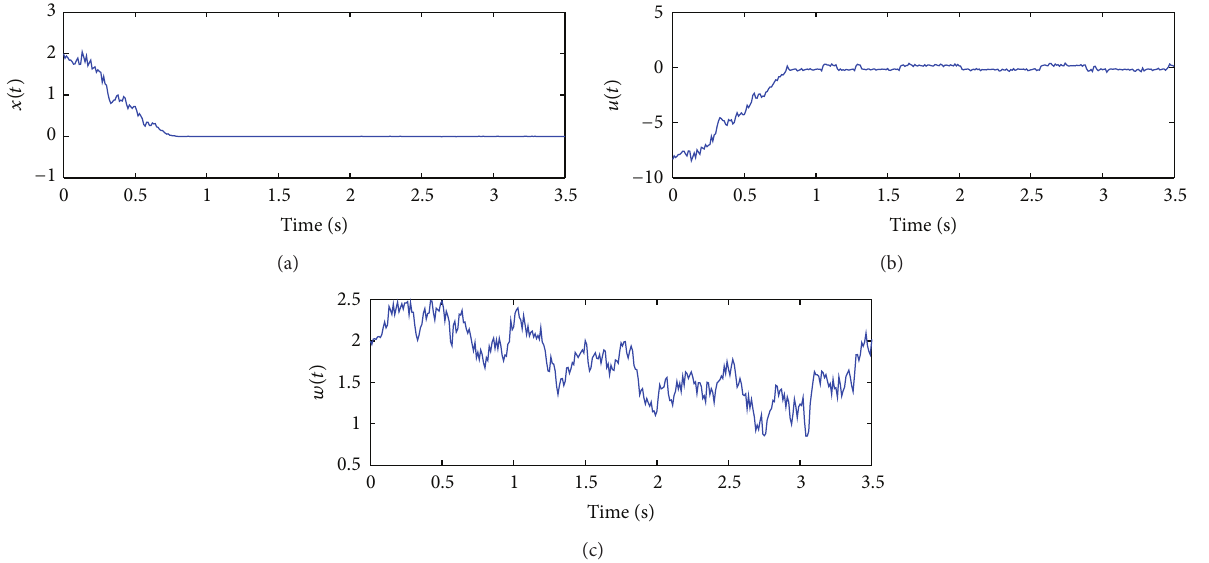
Figure 2: The response of the state 𝑥(𝑡) , the control 𝑢(𝑡) , and the Wiener process 𝑤(𝑡) in Example 1 for initial conditions as 𝑥(0) =